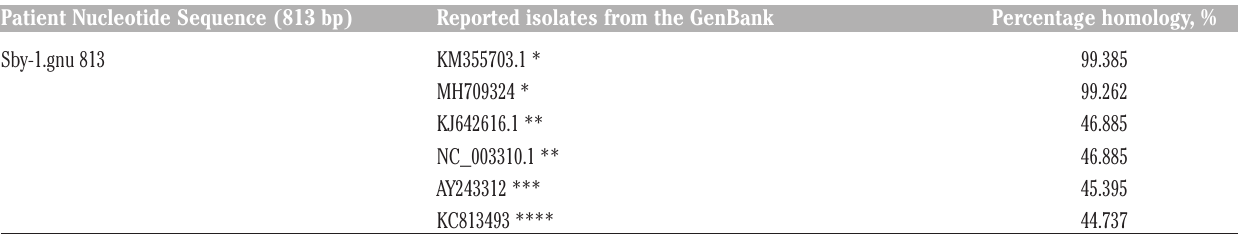
Table 1. Nucleotide sequence homology of the patient to other viruses from the GenBank database. Patient Nucleotide Sequence (813 bp)